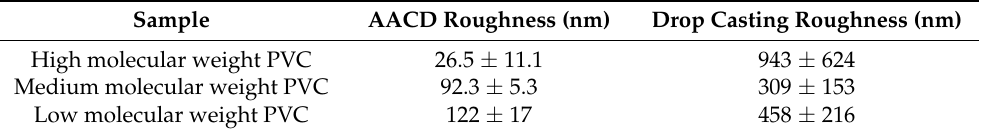
Table 1. Arithmetical mean roughness of the plasticized PVC films deposited onto gold electrodes by AACD and drop casting. Low, medium and high molecular weight PVC were deposited for 30 s under optimal